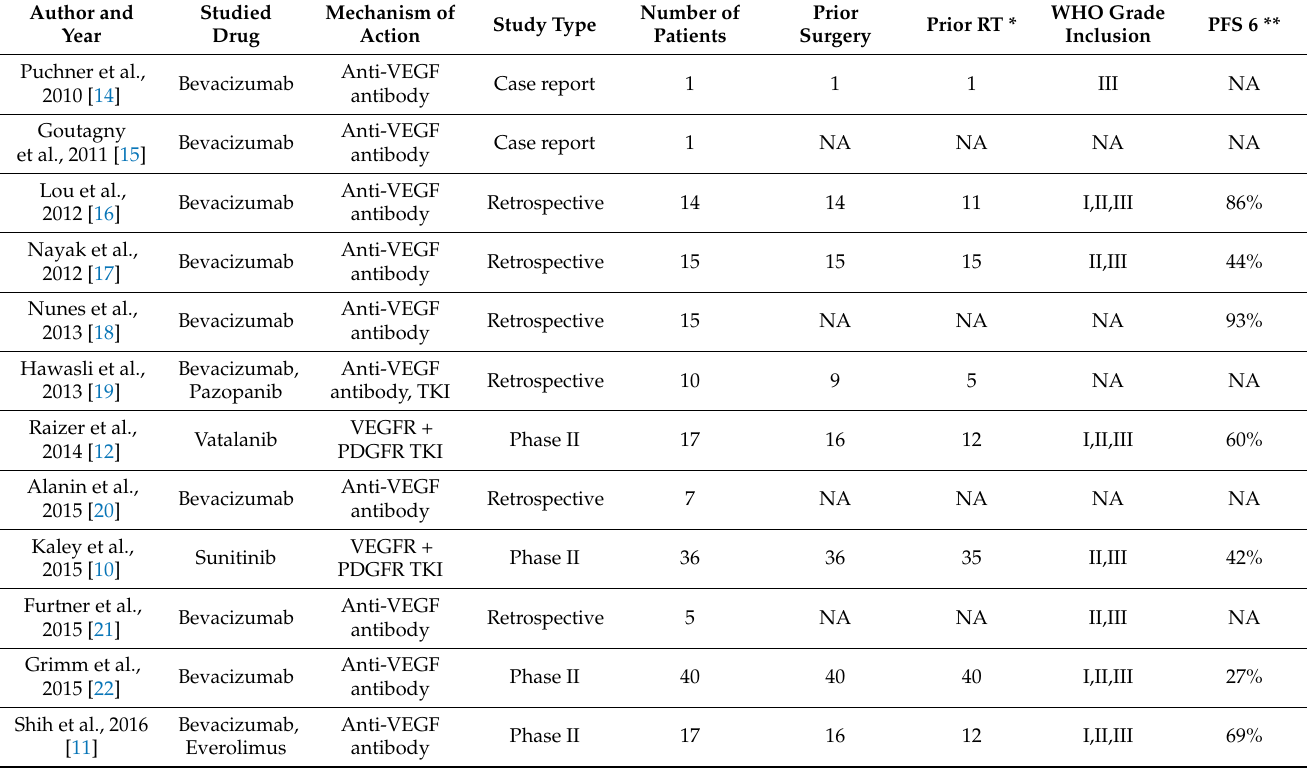
Table 1. Selected clinical studies evaluating the use of VEGF agents in meningioma